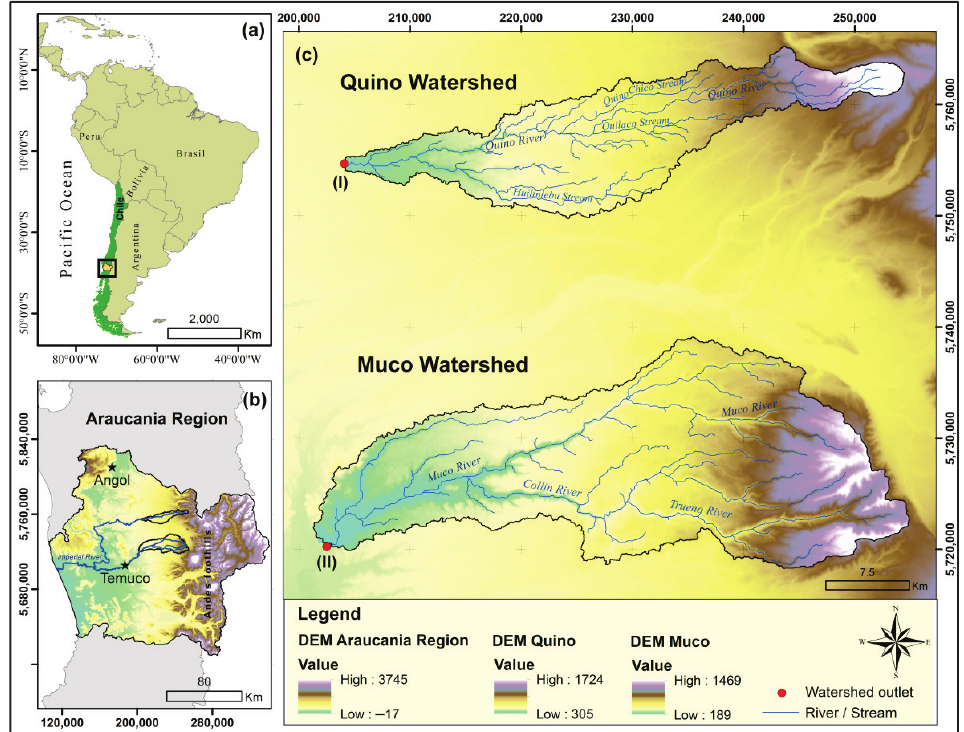
Figure 1. Location of study area. Context in South America ( a ), location in Chile ( b ), study watersheds ( c ). Fluviometric Stations: “Rio Quino en Longitudinal” (I) and “Rio Muco en Puente Muco”